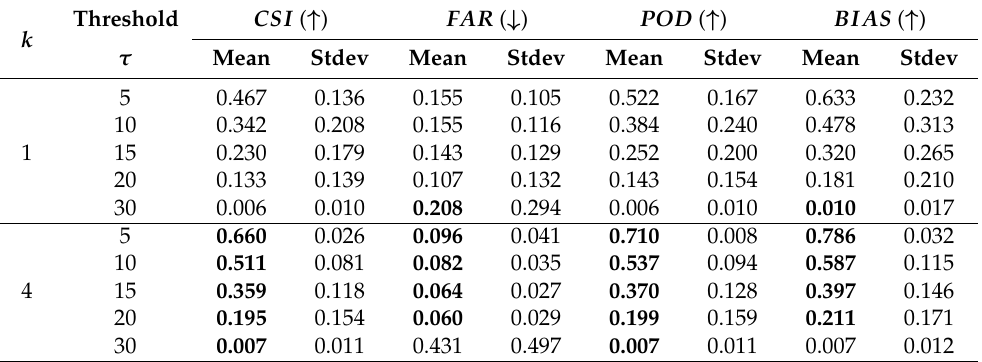
Table 5. The results for the classification evaluation metrics for predicting three time steps in the future using the MET case study. The means and standard deviations that were computed across the three experimental runs are shown. The best values for the performance metrics are marked with